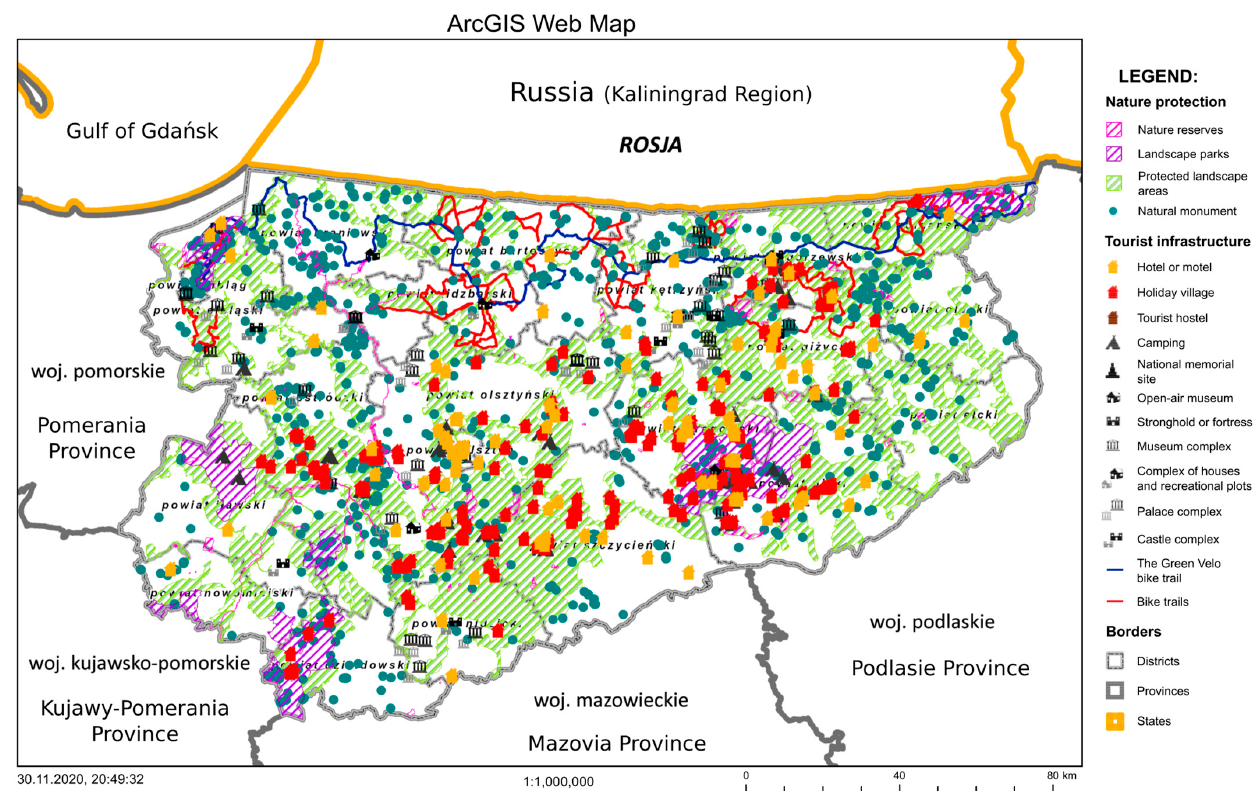
Figure 9. Protected nature sites and tourist infrastructure in the Warmia and Mazury Province.